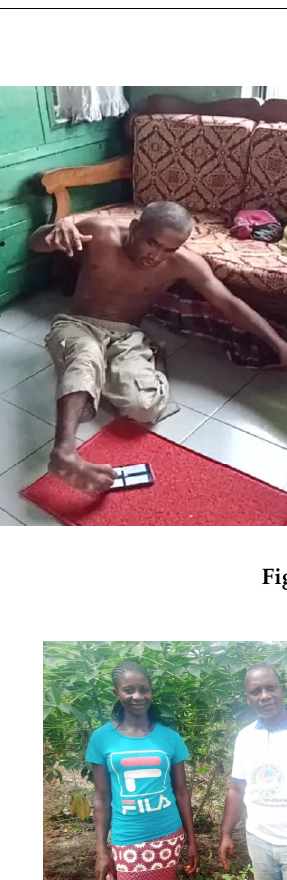
Figure 4. Alt-text: An empty white plastic chair.